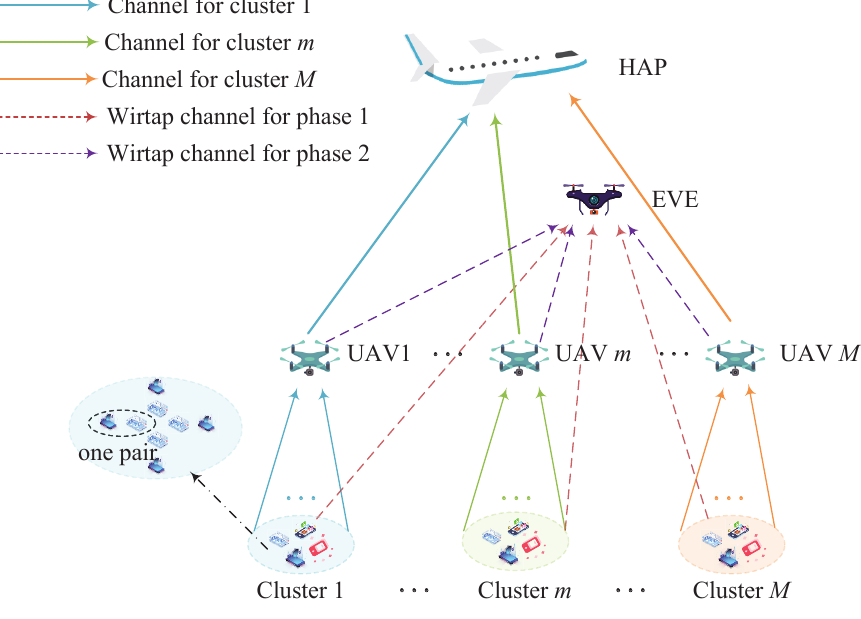
Figure 1. An HAP and UAVs collaboration framework in NOMA-enabled